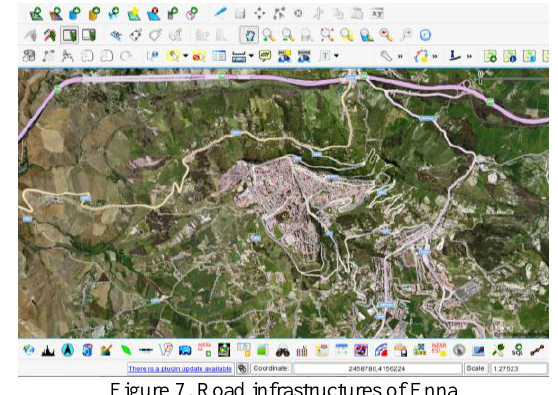
Figure 7. Road infrastructures of Enna